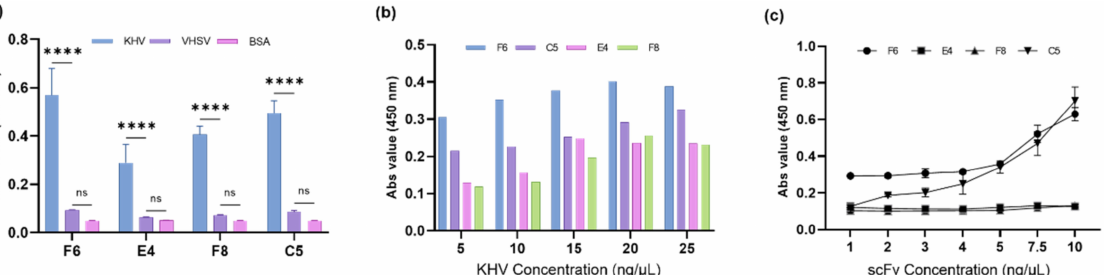
Figure 4. ( a ) Quantitative analysis of F6, E4, F8, and C5 scFv proteins against KHV virions (positive sample), VHSV virions (negative sample), and BSA (control) using an ELISA and two-way ANOVA to measure binding specificity. Data are presented as the mean ± SEM (**** p < 0.0001; ns, nonsignificant). ( b ) Sensitivity tests with 400 ng of scFv against serial dilutions of KHV virions demonstrate that F6 and C5 have a higher affinity to virion antigens than the others at a concentration as low as 5 ng/ µ L. ( c ) Sensitivity test using a series of scFv concentrations (1–10 ng/ µ L) against 10 ng/ µ L KHV